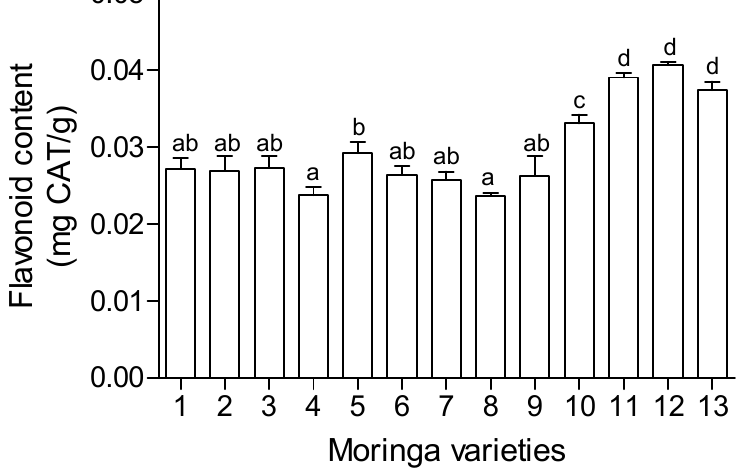
Figure 3. Flavonoid content of thirteen Moringa oleifera cultivars introduced from different geographical locations around the world. 1. TOT4880; 2. TOT4977; 3. TOT5077; 4. TOT5028; 5. TOT5169; 6. SH; 7. TOT4893; 8. CHM; 9. TOT5330; 10. TOT7266; 11. TOT4100; 12. TOT4951; 13. Limpopo. Values expressed as catechin equivalents (CAT) per gram of plant extracts. Mean values (±SE) on bar graphs with different letters are significantly different ( p < 0.05; n =